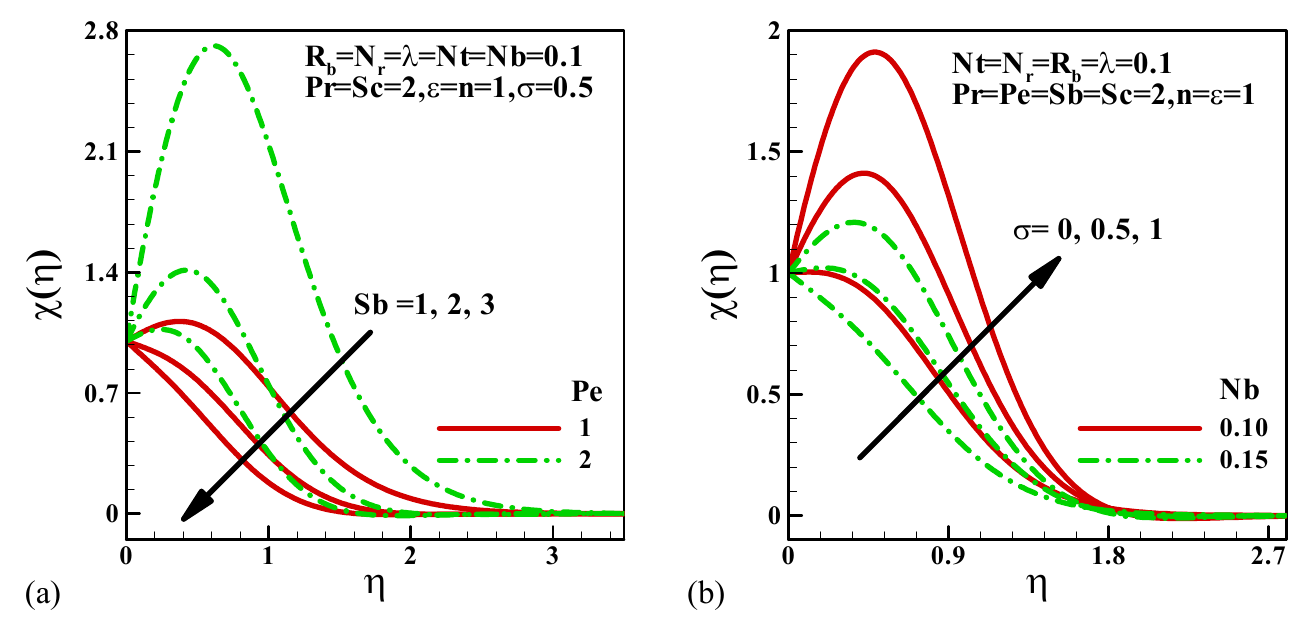
Figure 6. Variation of dimensionless motile micro ‐ organism density with ( a ) the bioconvection Schmidt number with different Peclet numbers and ( b ) the bioconvection constant and Brownian motion parameter.